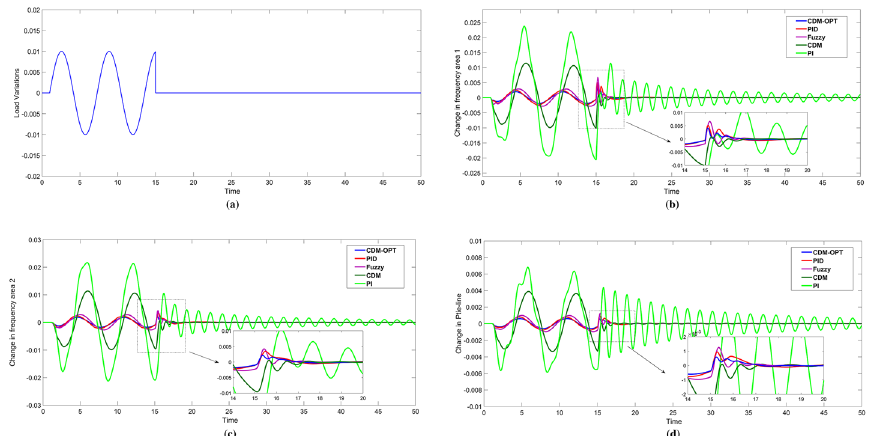
Fig. 6 Case 3 Signals: a Sinusoidal load variation. b Frequency in area 1. c Frequency in area 2. d Tie-line between areas